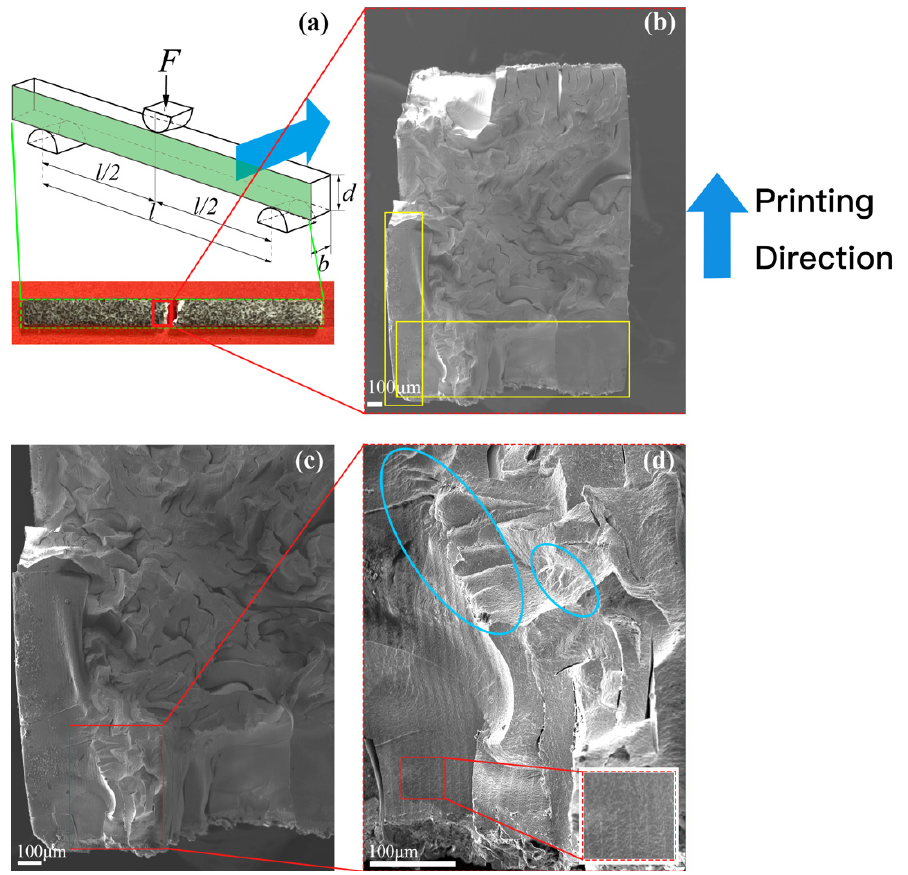
Figure 12. The SEM images of three-point vertical loading. ( a ): Schematic diagram of the experiment; ( b – d ): Fracture morphology and partially enlarged views.